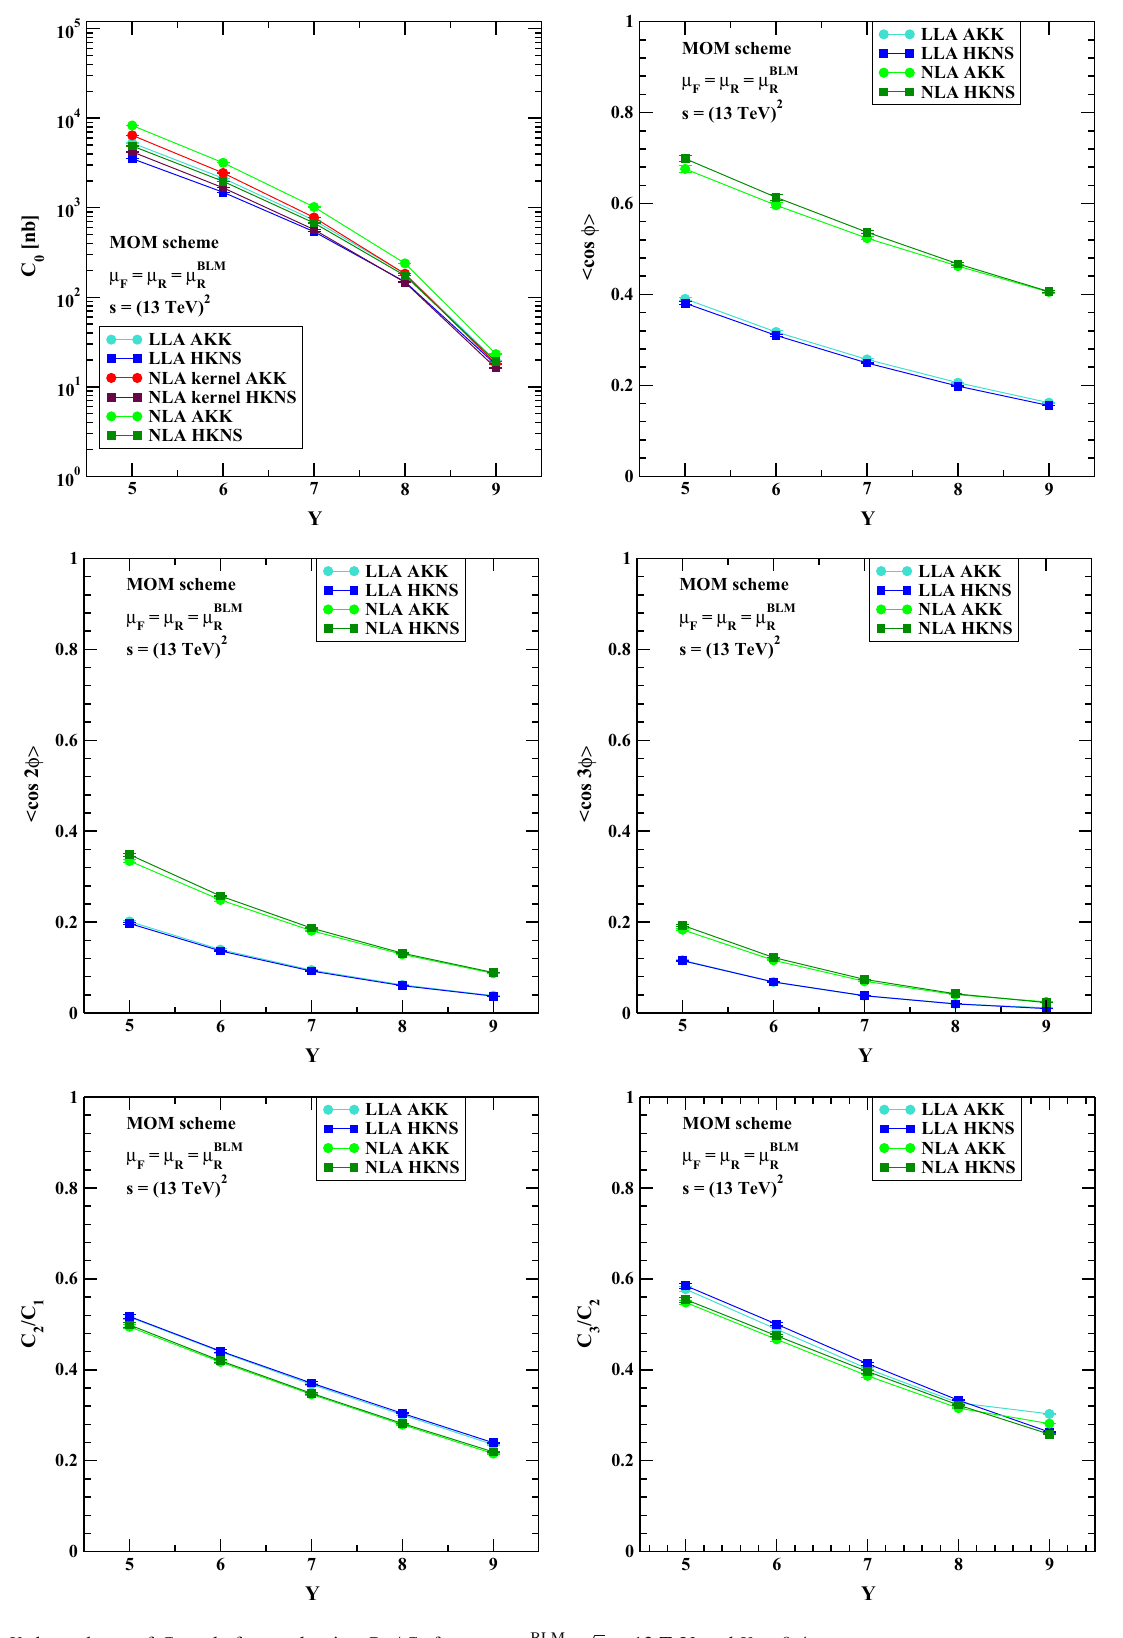
Fig. 8 Y -dependence of C 0 and of several ratios C m / C n for μ F = μ BLM